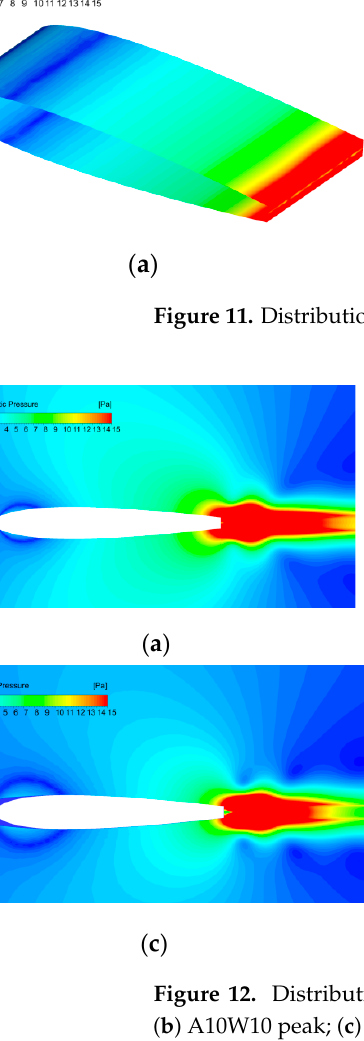
Figure 11. Distribution of the pressure fl uctuations on the airfoil ʹ s surface: ( a ) baseline; ( b ) A10W10.